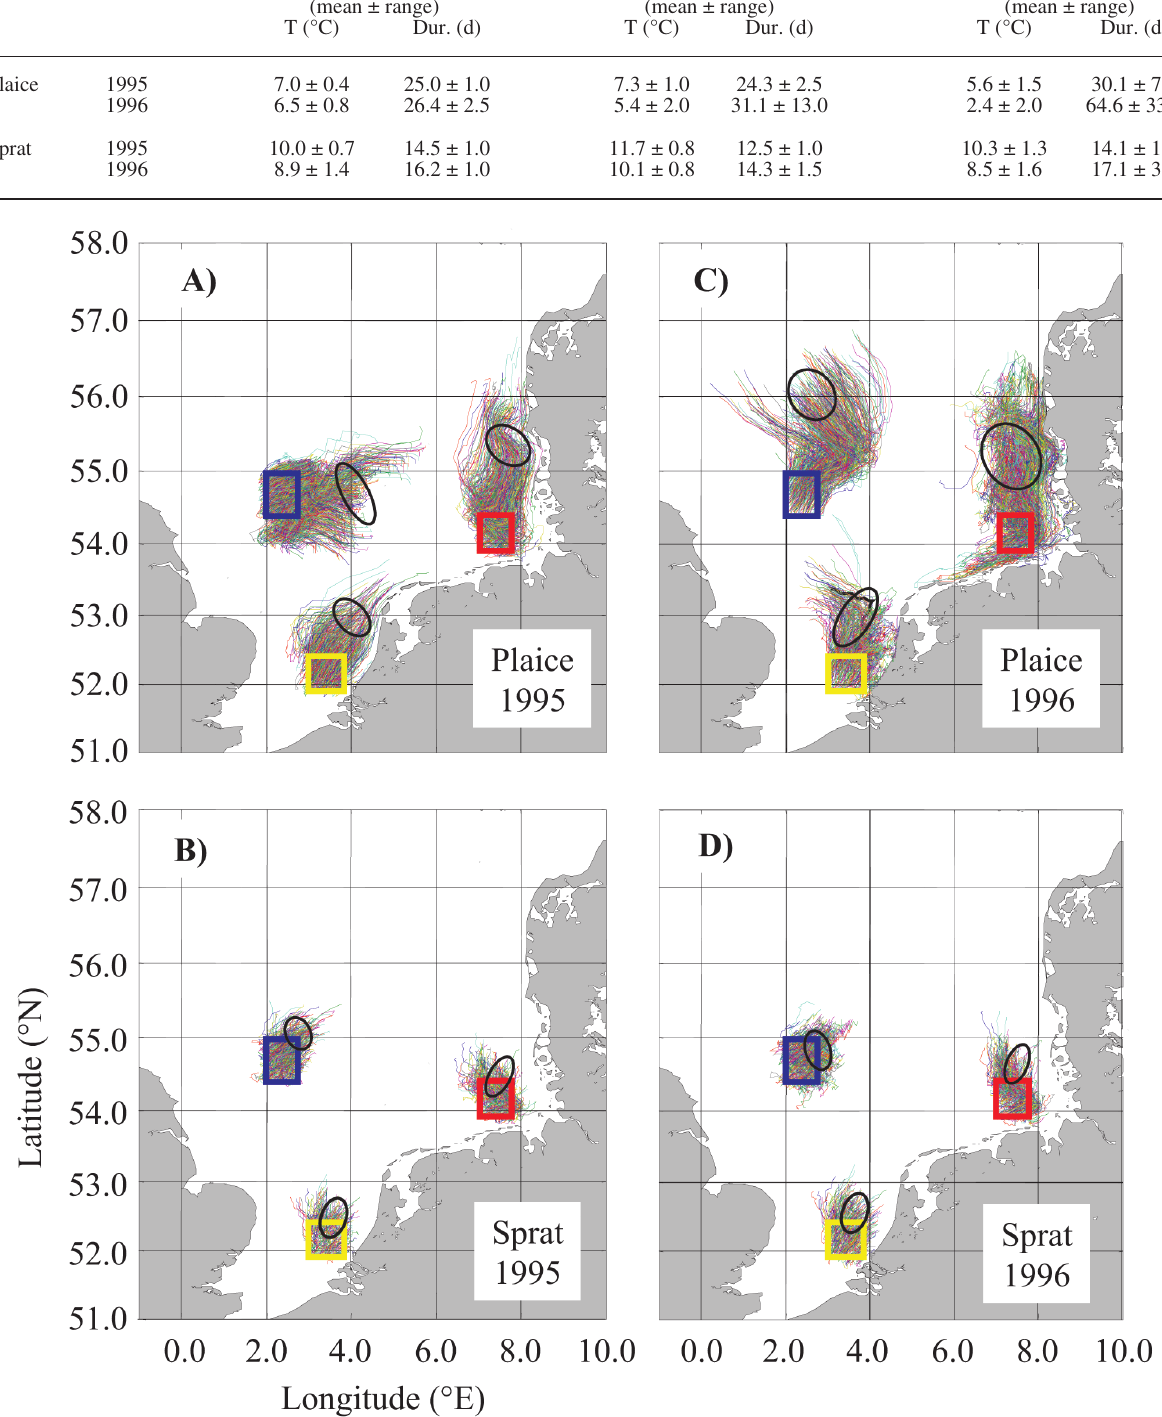
F IG . 8. – Comparison of drift trajectories of endogenous feeding stages (eggs and yolksac larvae) of plaice and sprat released at three spawning sites (black squares). The ensemble mean location at the end of the yolksac phase is represented by a dispersion ellipse (note, many individual trajectories overlay one another, obscuring the mean trajectory). Specific information regarding drift trajectories is provided in Table